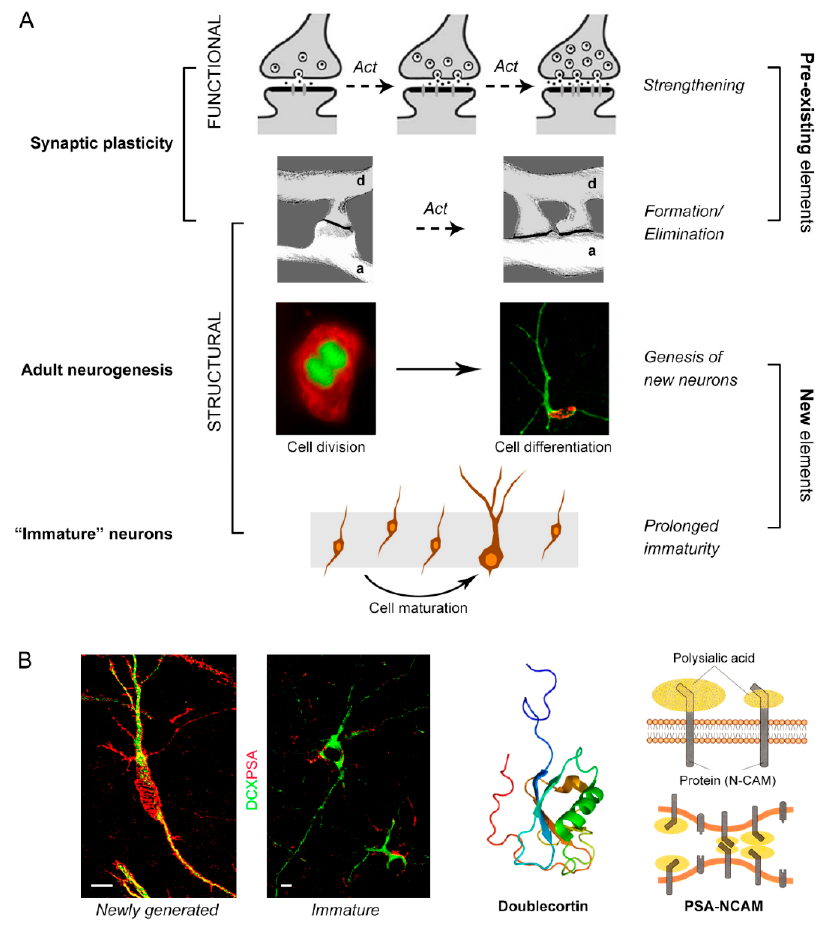
Figure 1. Different types of plasticity in the central nervous system. ( A ) Functional synaptic plasticity (strengthening of synaptic contacts) and structural synaptic plasticity (formation and elimination of synapses) involve modification of contacts among pre-existing elements (images inspired from [24,27]); Act , neuronal activity. Adult neurogenesis, a form of striking structural plasticity implying a change in the number of neurons, and prenatally generated neurons continuing to express molecules of immaturity for long time (“immature” neurons), are thought to provide a similar outcome through progressive maturation and, possibly, integration, thus providing examples of “whole cell structural plasticity”. ( B ) The main neuronal markers of immaturity (the cytoskeletal protein doublecortin, DCX, and the non-adhesive, polysialylated form of the neural cell adhesion molecule, PSA-NCAM) are co-expressed by both categories of neurons involved in whole cell structural plasticity (WCSP), namely, newly generated and non-newly generated immature neurons. Left, rabbit cerebellum; right, mouse cerebral cortex. Scale bars: 5 µm.